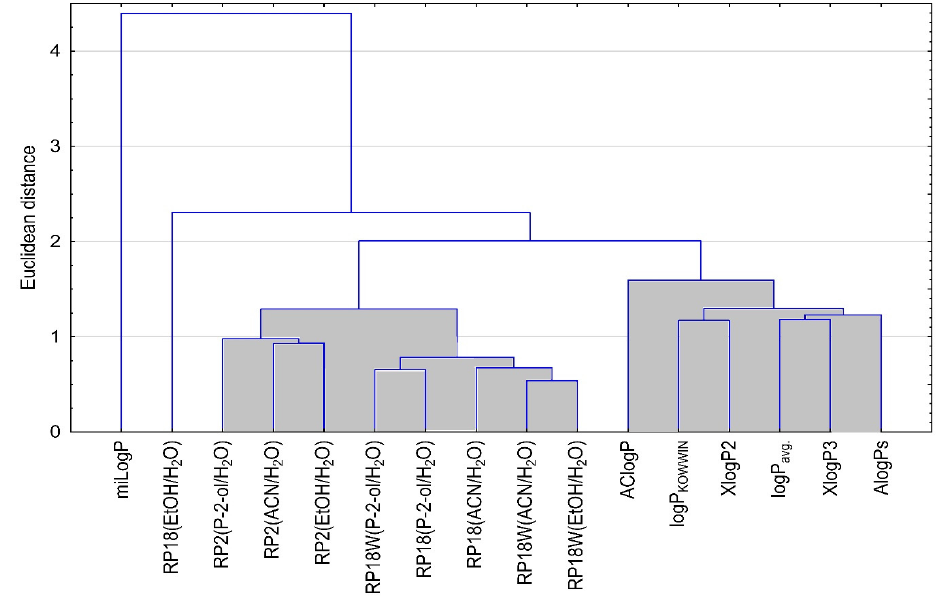
Figure 3. Analysis of similarities of lipophilicity values for tested compounds.